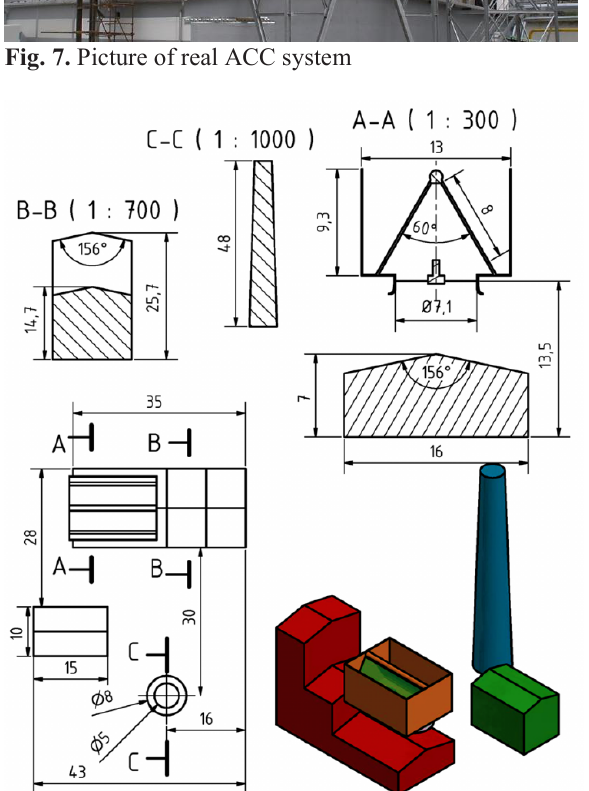
Fig. 8. Scheme of ACC model with dimensions in meters